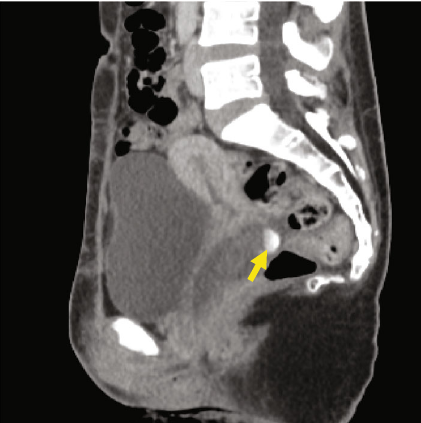
Figure 1: Pelvic computed tomography scan (sagittal view) reveals a large mass, which shows a dappled contrast fi lling on the arterial phase, located in the posterior vaginal wall (arrow).